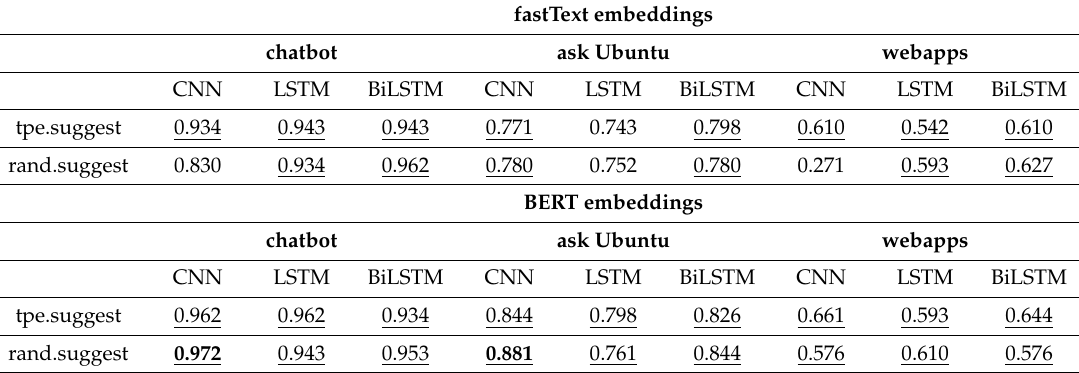
Table 9. Evaluated accuracies on the Russian testing datasets with optimized models. For the other notation, see Table 5.